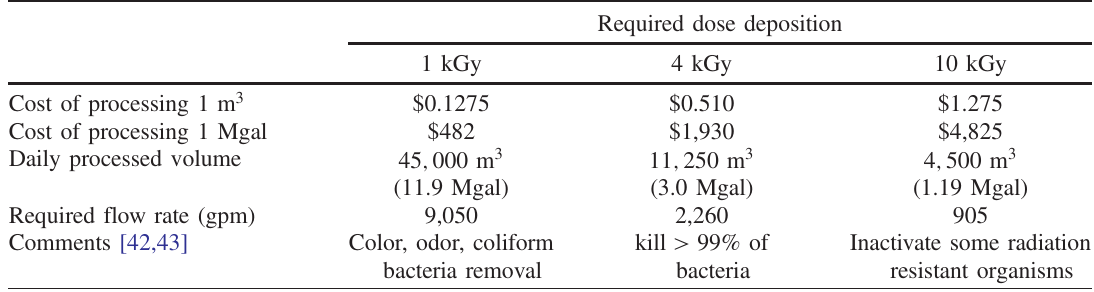
TABLE IX. Wastewater treatment cost and daily processing capability for various dose requirements. Required dose deposition